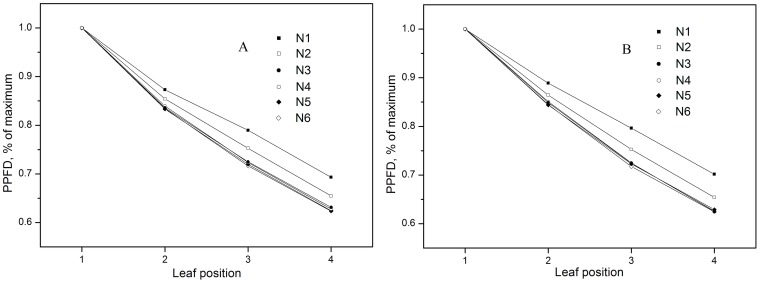
Photosynthetic photon flux density (PPFD) in relation to canopy position.Data are represented in terms of the percentage of PPFD measured at the uppermost canopy position. Measurements were taken at midday at the flag leaf and the next three leaves (2nd, 3rd, and 4th leaves) on (A) Sept. 1, 2008, and (B) Aug. 26, 2009. N1, N2, N3, N4, N5, and N6 indicate N application rates of 0, 75, 150, 225, 300, and 375 kg N ha−1, respectively.